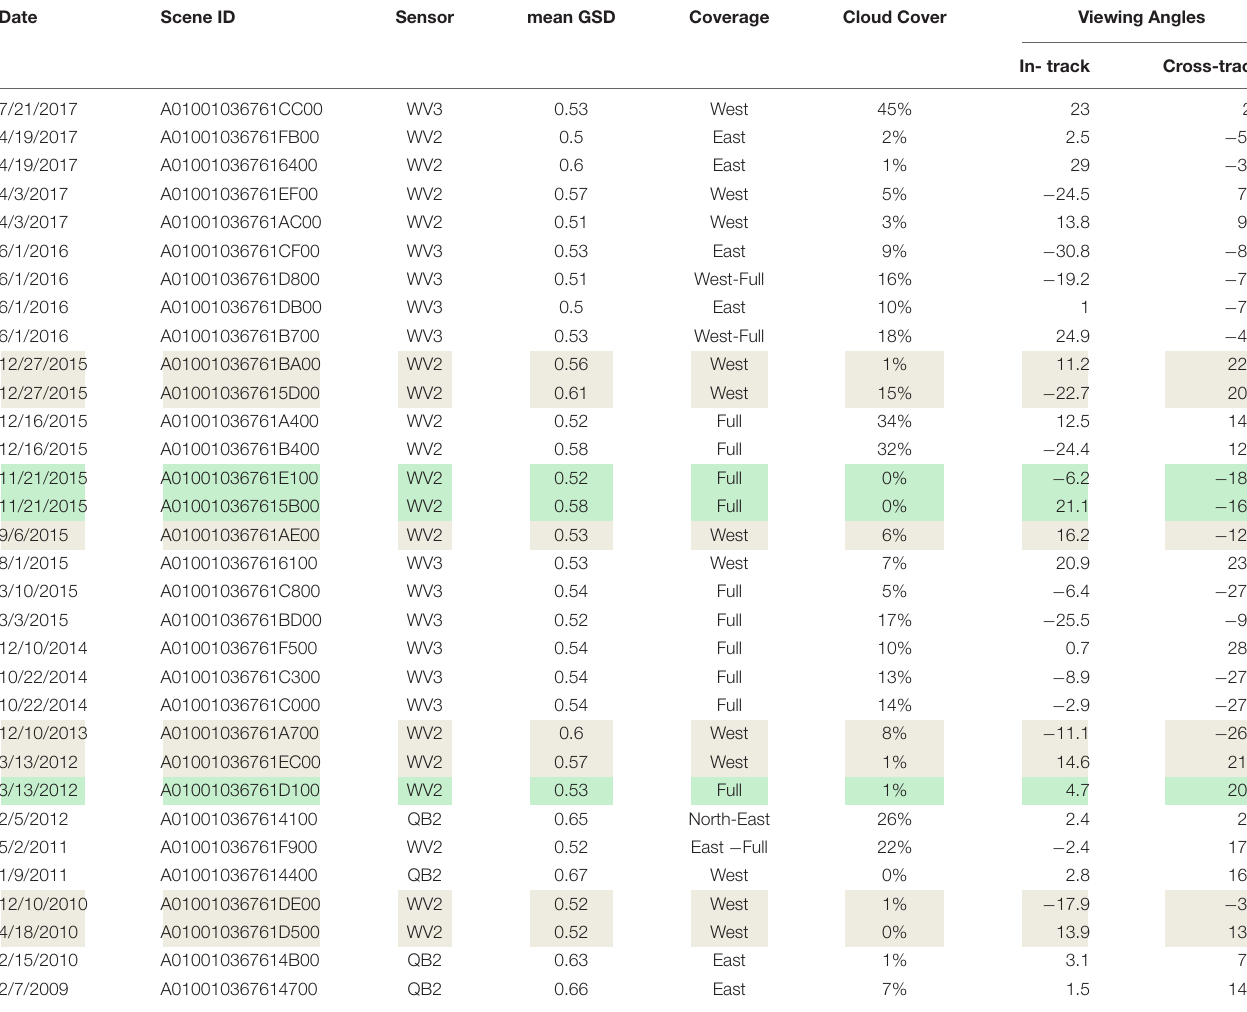
TABLE 2 | DigitalGlobe basic image products, scenes of the prime image triplet are marked in green, scene of the MVS image stack marked in gray and